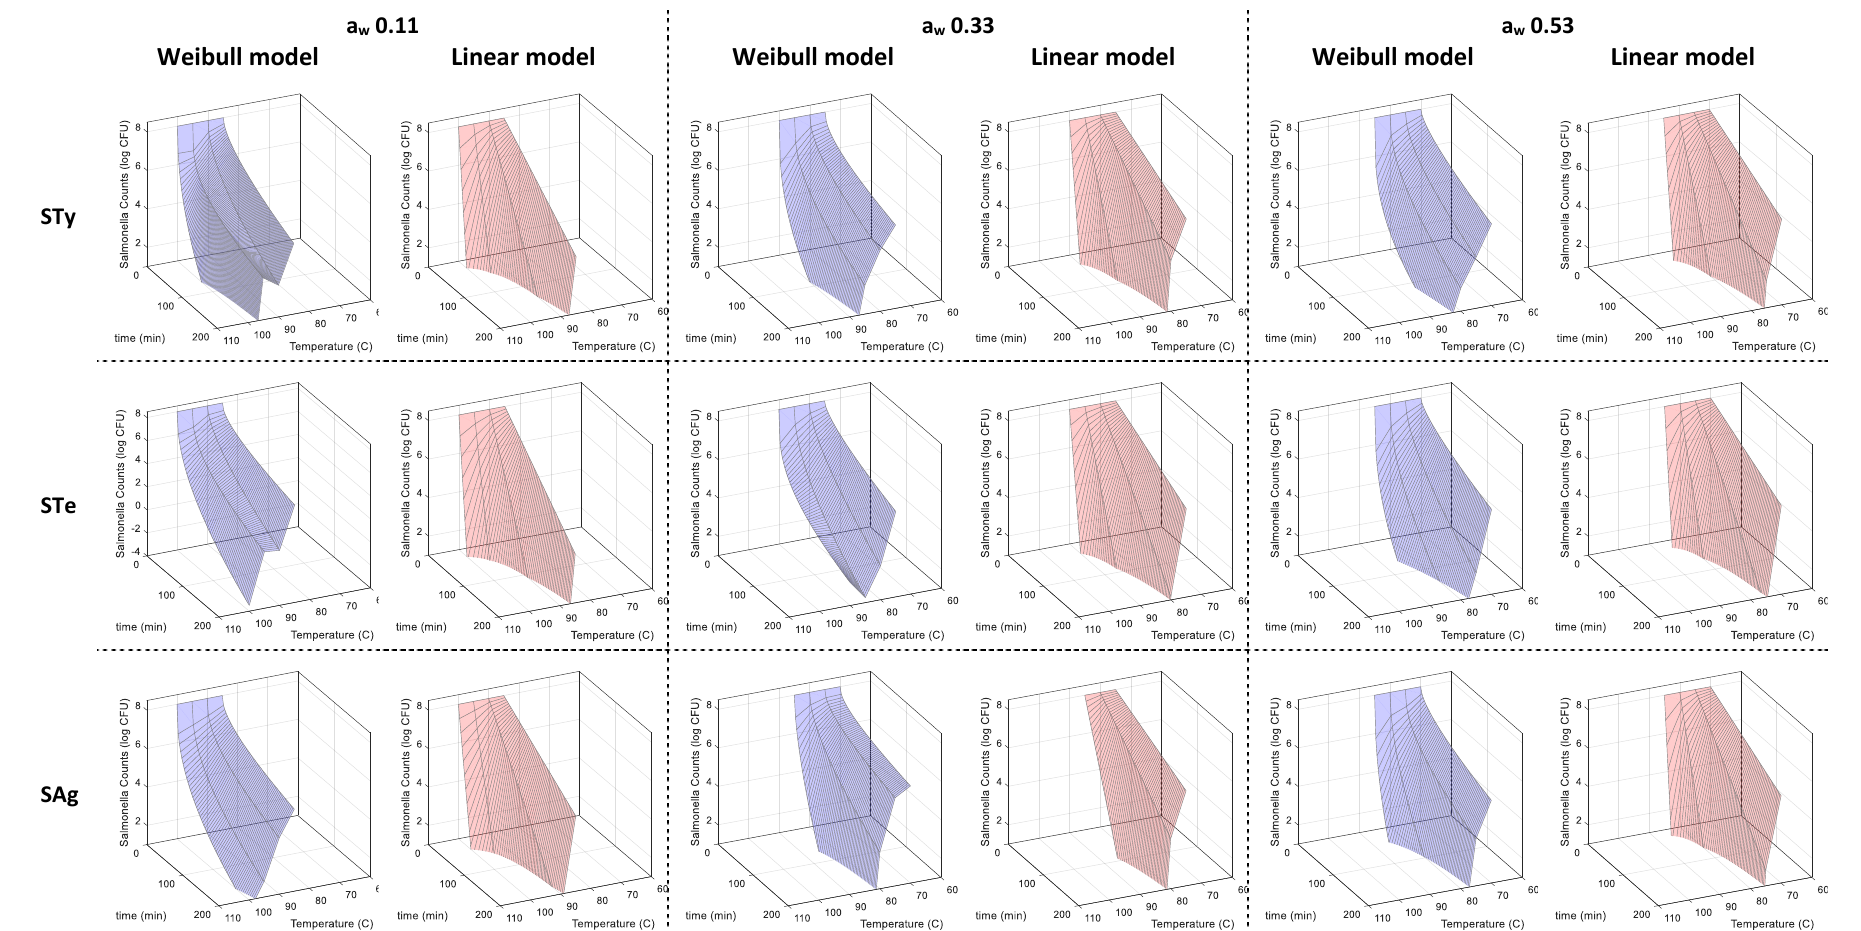
Figure 2. Thermal inactivation rates of Salmonella enterica serovars Typhimurium, Tennessee and Agona in toasted oats cereal (TOC) affected by water activity (a w ) and temperature in the presence of 25% sucrose. Weibull model fitting is represented in blue and linear model fitting is represented in red. STy, STe and SAg are abbreviations for serovars Typhimurium, Tennessee and Agona, respectively.